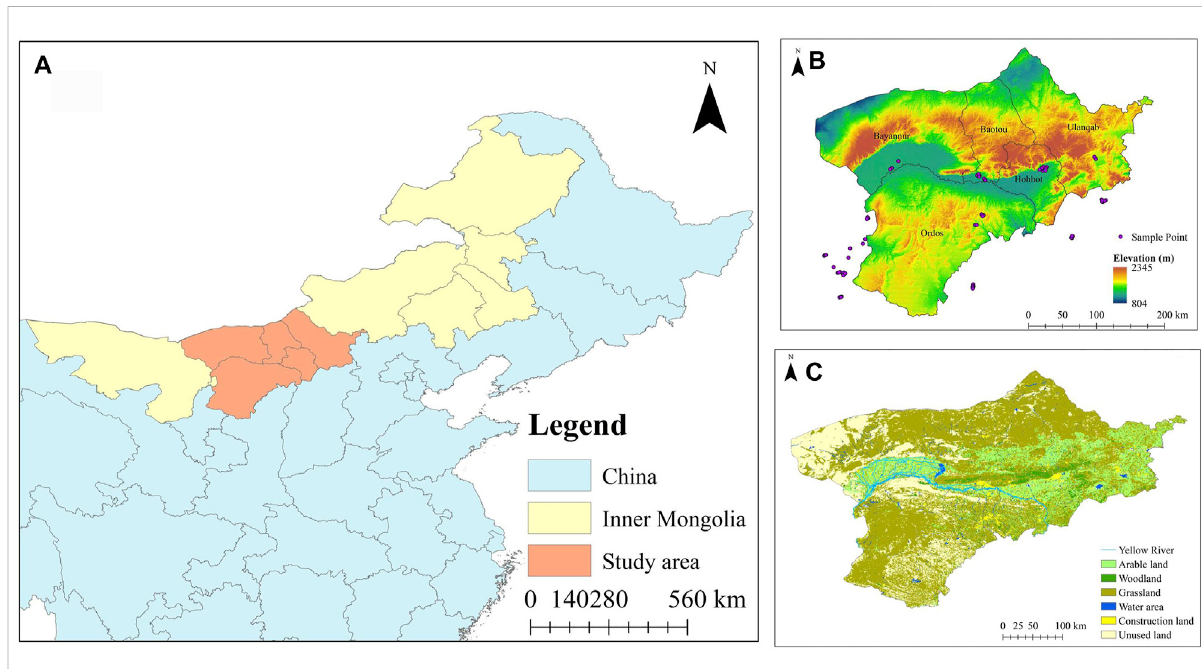
FIGURE 1 (A) Geographicallocationofthestudyarea; (B) SurfaceelevationandPM2.5monitoringstationsinthestudyarea; (C) Landusetypesinthestudy